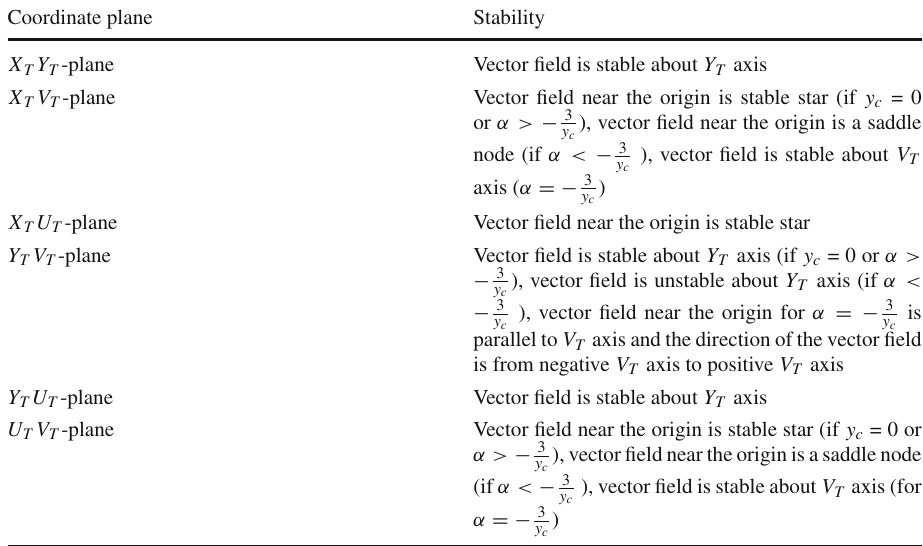
Table 6 Stability of the vector field on every coordinate plane for the critical point P